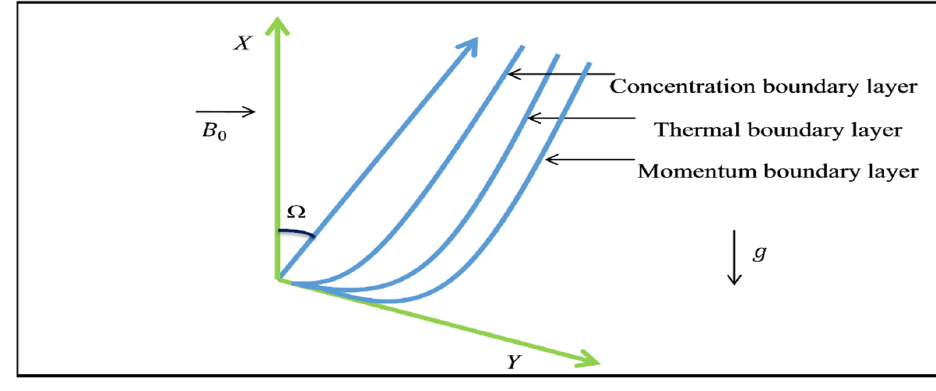
Figure 1. Physical structure with coordinates.